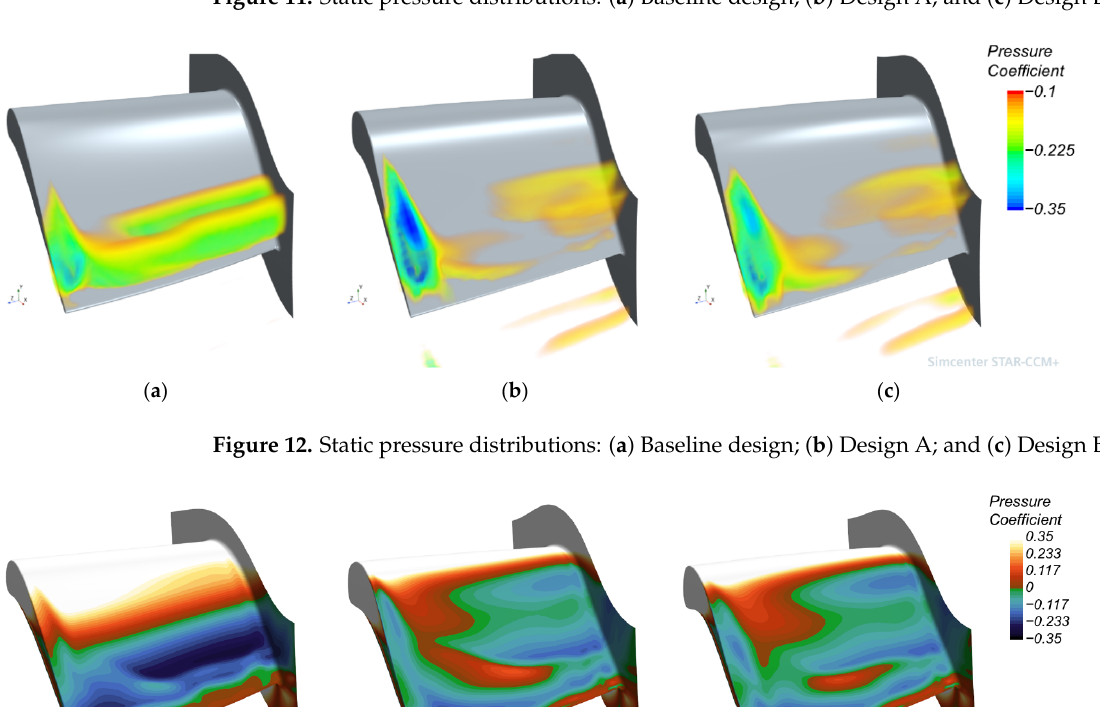
Figure 11. Static pressure distributions: ( a ) Baseline design; ( b ) Design A; and ( c ) Design B.